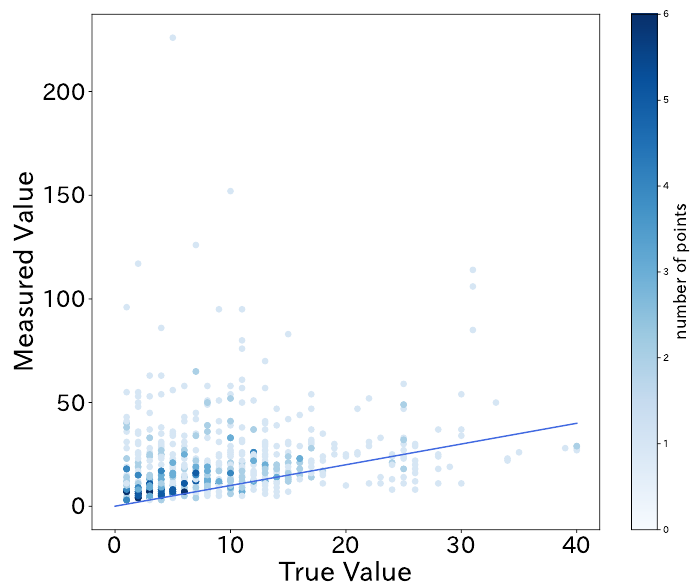
Figure 6. Measured values (BD address counts) versus true values (passenger counts) obtained from raw